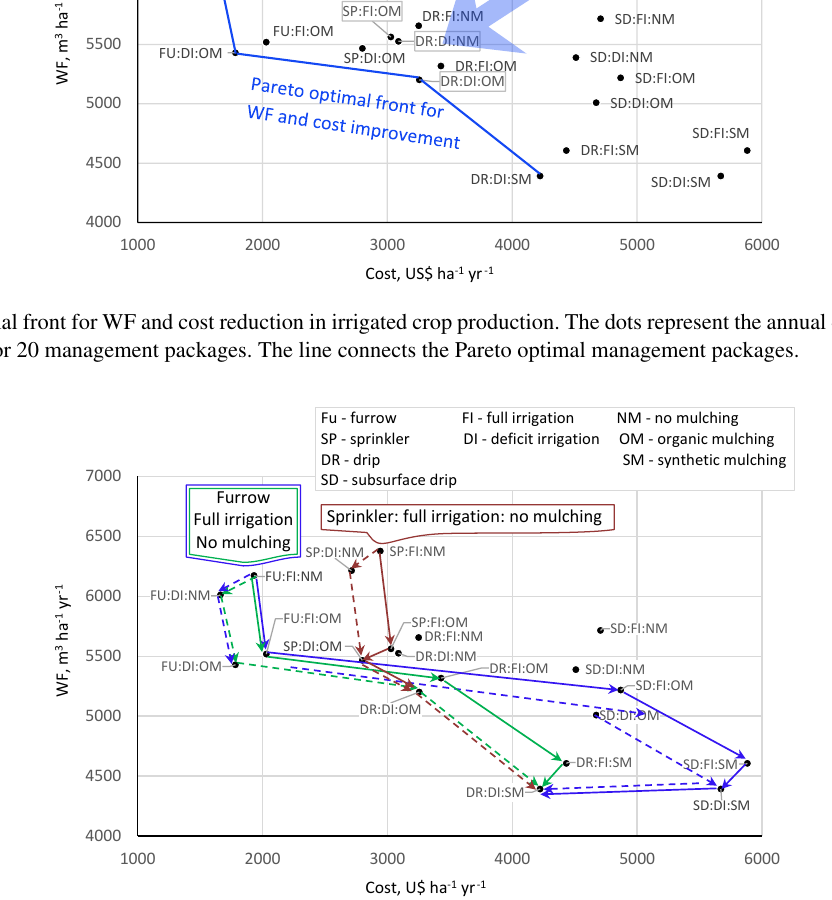
Figure 6. WF reduction pathways for maize from two baseline management packages: full irrigation and no mulching with either furrow or sprinkler